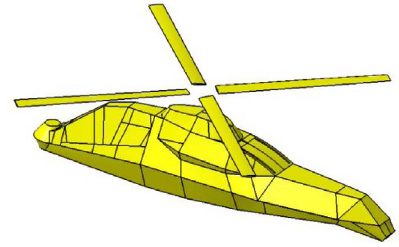
Figure 4. Helicopter model with RAH-66 fuselage.